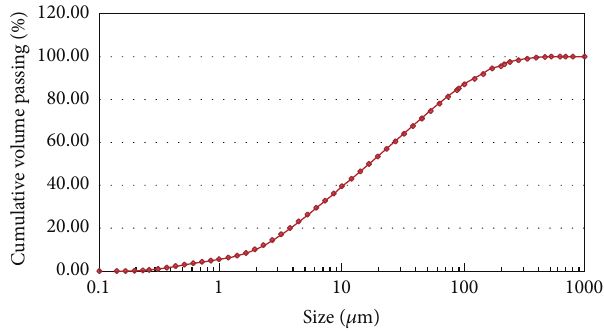
Figure 2: Cumulative particle size distribution of fly